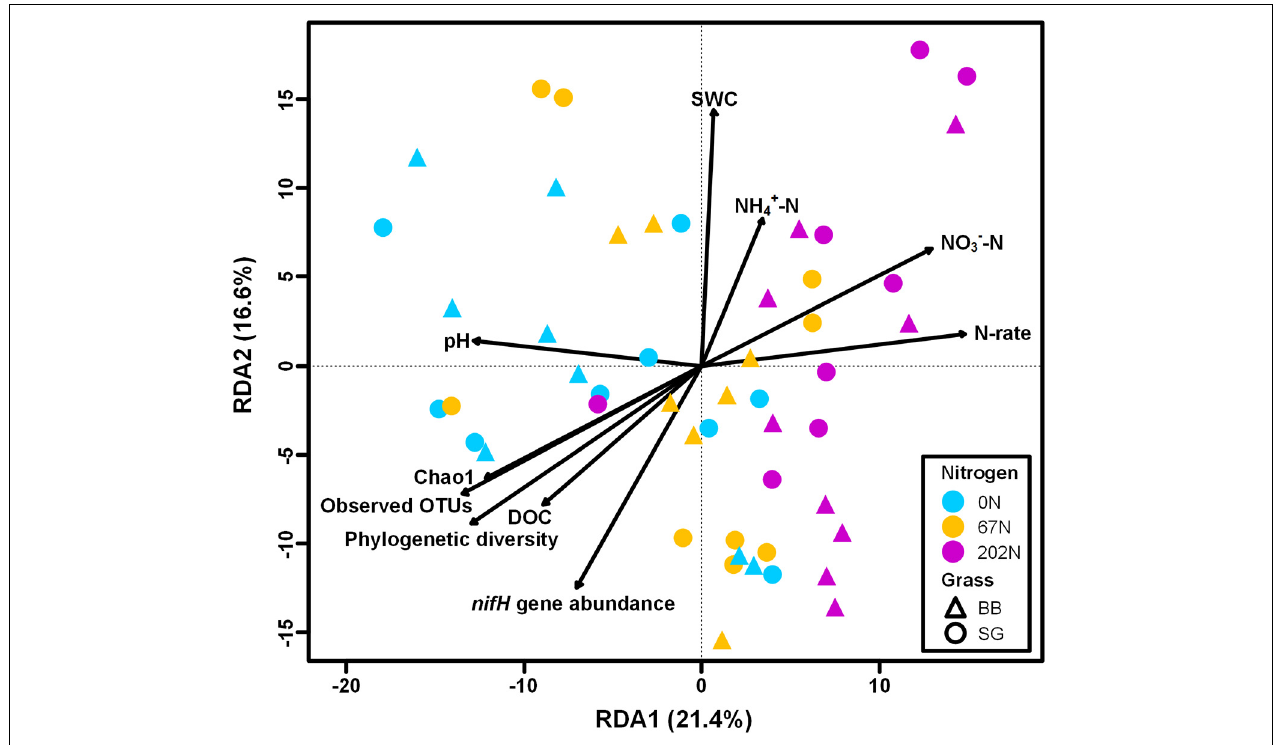
FIGURE 9 | Redundancy analysis (RDA) of diazotrophic microbial community (circle and triangle symbols) with environmental factors, nifH gene and transcript abundances, and community diversity metrics as predictor variables; significant predictors are indicated with arrows. 0N, no N fertilization; 67N, 67 kg N ha − 1 fertilization; 202N, 202 kg N ha − 1 fertilization; SG, switchgrass; BB, big bluestem; SWC, soil water content; DOC, dissolved organic C; N-rate, N fertilization